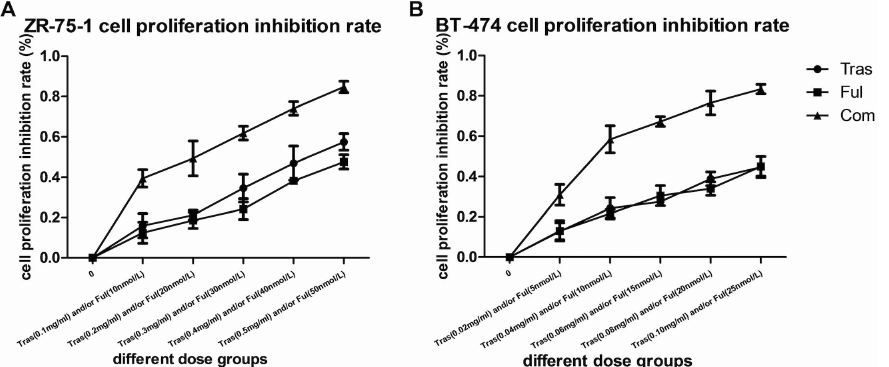
Fig 1. Drug dose versus ZR-75-1 cell proliferation inhibition rate curve (A) and Drug dose versus BT- 474 cell proliferation inhibition rate curve (B) using trastuzumab or fulvestrant treatment or both. After 72h of continuous exposure to drugs (either trastuzumab or fulvestrant as singleagents) highercell proliferation inhibitionrates were observedwith increasingdrug concentrations (P < 0.05). The combination of both drugs led to much stronger effect comparedwith individual drug treatments in both cell lines (P < 0.05); ED 50 values have been indicatedin Table